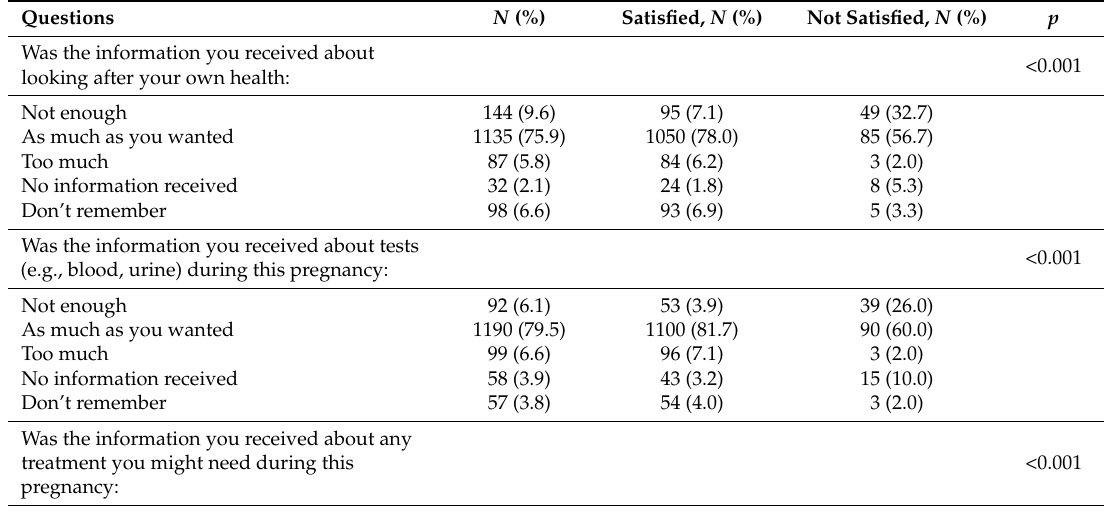
Table 3. Bivariate associations between satisfaction with antenatal care and answers to the questions on the information received in antenatal